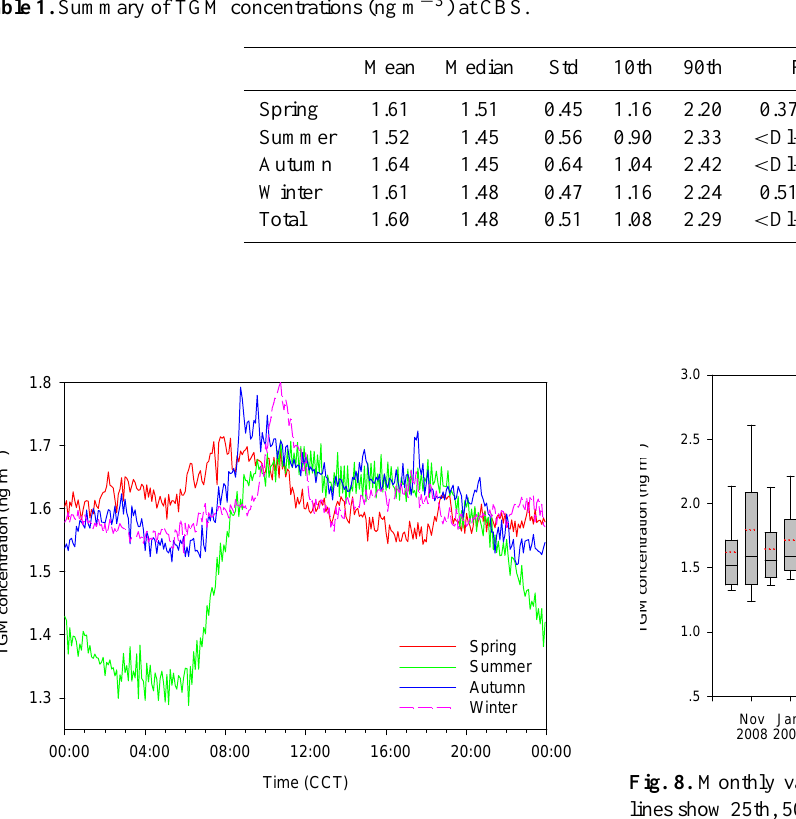
Fig. 7. Diurnal variations of TGM at CBS during the whole study period.